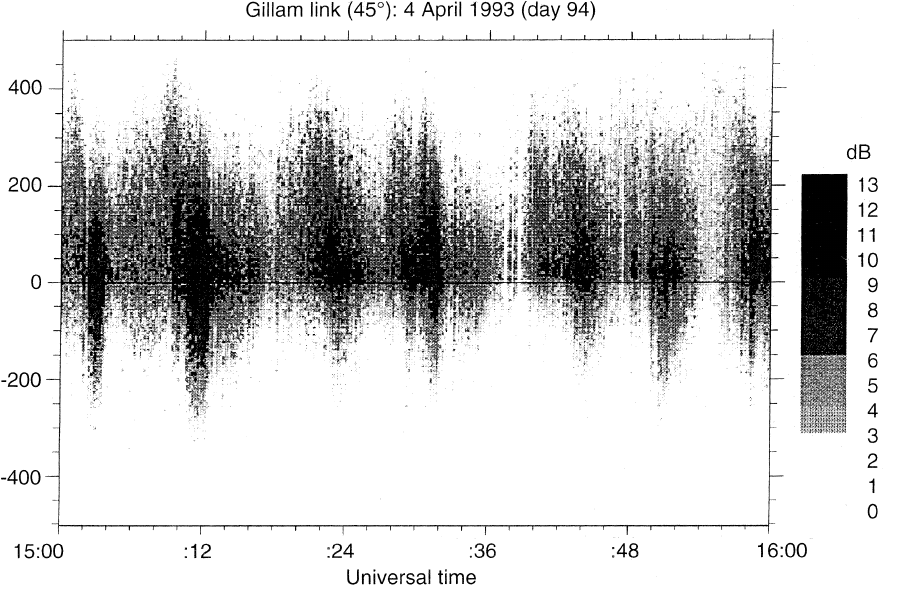
Fig. 3. Doppler spectra of co- herent echoes received on April 4, 1993 on the Gillam-Saskatoon 50-MHz radio link. To obtain the mean velocity shift and spectral width the values in Hz should be multiplied by a factor 3.1